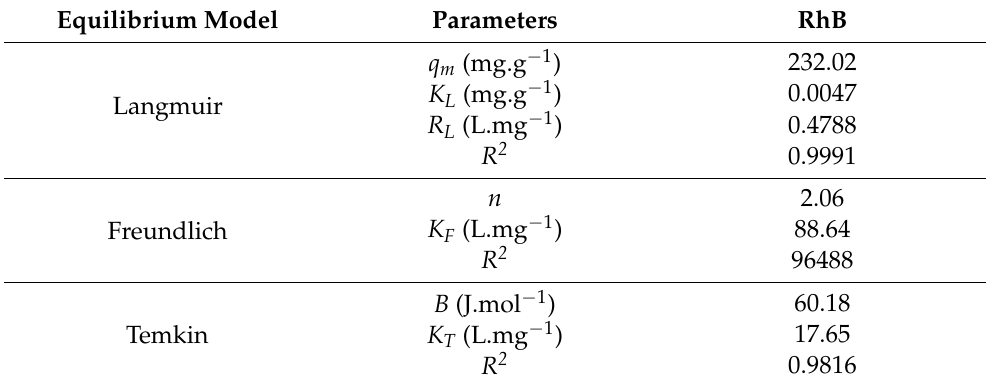
Figure 7. Isotherm investigation for RhB sorption on MgTiO 3 @g-C 3 N 4 using ( a ) Nonlinear LIM, FIM, and TIM; ( b ) Linearized LIM; ( c ) Linearized FIM; ( d ) Linearized TIM. Table 3. Different equilibrium Isotherms’ constants for RhB dye adsorption by MgTiO 3 -g-C 3 N 4 na- nomaterial.